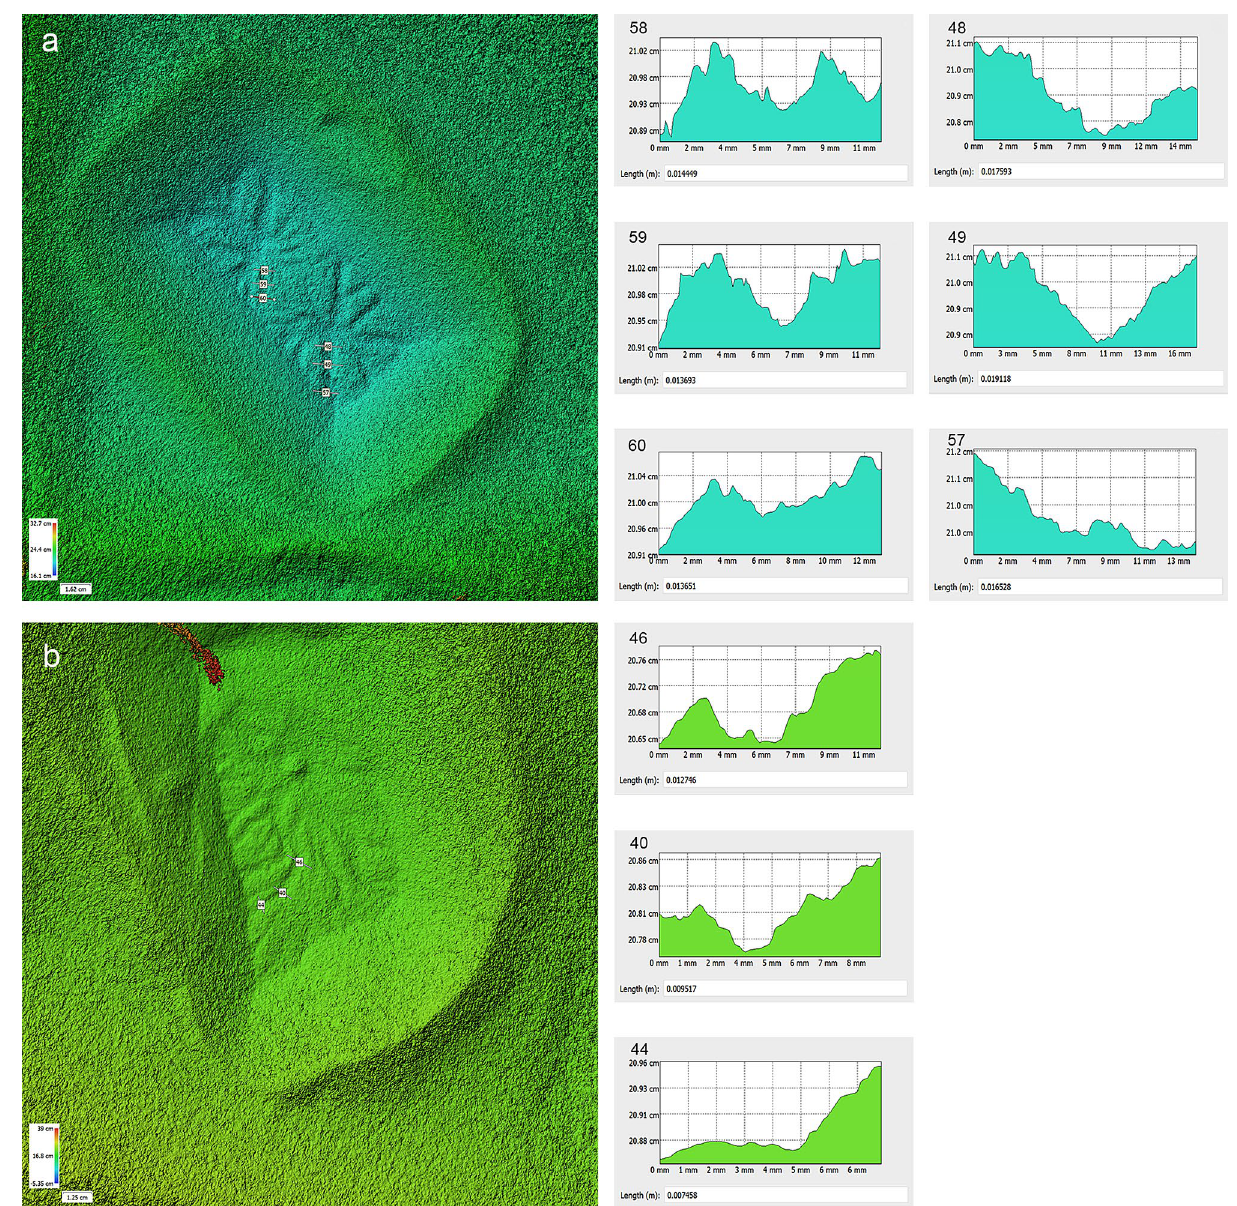
Figure 7. Examples of DEMs created in the laboratory with cross-sections showing depth of troughs decrease away from araneiform centre, as on Mars. ( a ) Shows double araneiforms on 250–425 µ m grains. ( b ) Shows an araneiform on 150–250 µ m grains. Graphs show decrease in trough depth further away from the central pit. Sample depths were calculated by averaging the heights of the inversion points at each side of the trough and taking away the minimum point, using linear transects to calculate depth in Agisoft Metashape. Transect numbers are arbitrary. ( a ) Transect 58 was 0.102 cm deep, transect 59 was 0.0859 cm deep, transect 60 was 0.07 cm deep. Transect 48 was 0.189 cm deep, transect 49 was 0.123 cm deep, transect 57 was 0.06 cm deep. ( b ) Transect 46 was 0.071 cm deep, transect 40 was 0.041 cm deep, transect 44 was 0.025 cm